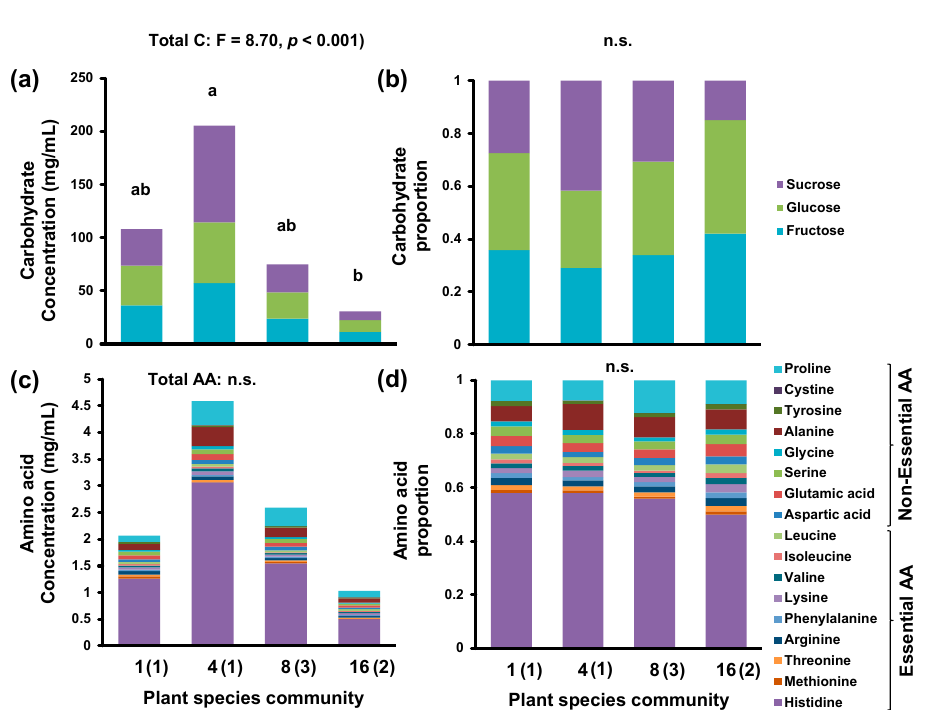
Figure 1. Carbohydrate ( a ) concentrations and ( b ) proportions as well as amino acid ( c ) concentrations and ( d ) proportions in nectar of Knautia arvensis growing in different plant communities with one, four, eight, and 16 different plant species. Concentration is given in mg/mL. Amino acids are divided into non-essential and essential amino acids (sensu [32]). Numbers in parentheses give the number of plots sampled per plant community. Letters above the bars indicate the significance of differences between plant species communities, while n.s. indicates no significance.